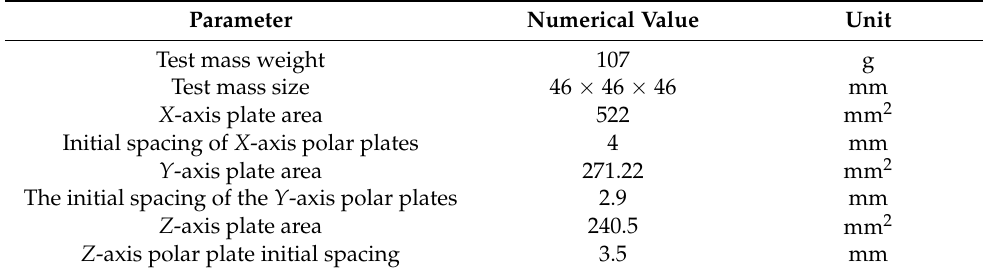
Table 3. Sensitive structural parameters.